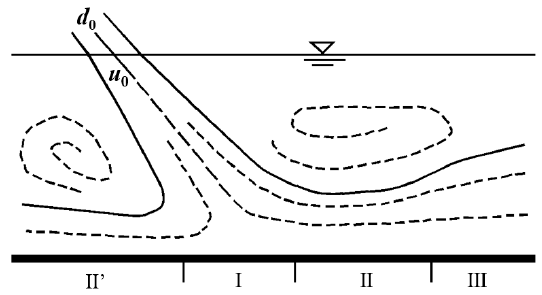
Figure 7. Schematic diagram of an impinging jet model [31].